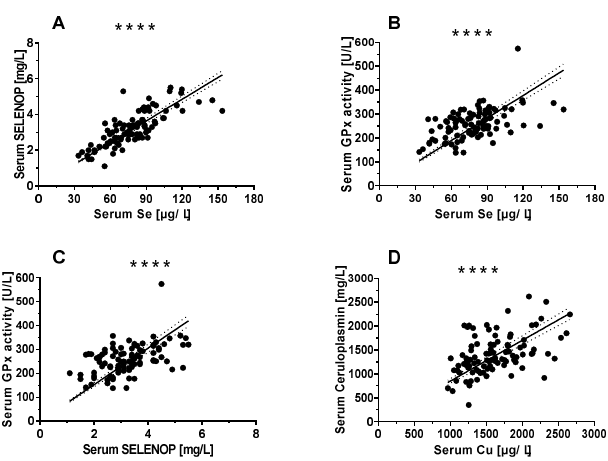
Figure 1. Selenium (Se) and Copper (Cu) status assessment from serum of the full study cohort. The concentrations of biomarkers of Se status correlate significantly in the serum samples analysed, and positive and tight correlations are observed for ( A ) selenoprotein P (SELENOP) and total Se ( n = 96 pairs of data, r = 0.792, p < 0.0001), ( B ) GPx3 activity and total Se ( n = 96, r = 0.491, p < 0.0001), as well as ( C ) GPx3 activity and SELENOP ( n = 96, r = 0.470, p < 0.0001). ( D ) Similarly, both biomarkers of Cu, i.e., ceruloplasmin (CP) and total Cu concentrations show a positive and tight correlation across the full range of values in the complete cohort of serum samples ( n = 96, r = 0.475, p < 0.0001). Correlations were analysed by Spearman’s correlation test. p -values < 0.05 were considered statistically significant; **** indicates p < 0.0001. Nutrients 2020 , 12 , x FOR PEER REVIEW The SSc patients displayed disease-specific differences in the TE status biomarkers in comparison to HC (Figure 2). To further subdivide the analyses, the group of SSc patients was differentiated according to presence or absence of PAH. A gradual decrease in Se status from HC to patients with SSc and then with SSc-PAH was observed. The group of SSc-PAH patients displayed the lowest Se status, i.e., significantly reduced concentrations of Se (Figure 2A), and SELENOP (Figure 2B), as well as reduced GPx3 activity (Figure 2C). Notably, the average levels of all three Se status biomarkers were consistently lower in patients with SSc-PAH than in HC. In comparison to established reference ranges from literature [21,43], the SSc patients displayed a relative Se deficit (Table S1); the prevalence of Se deficiency (SSc-PAH vs. SSc vs. controls) was 16.0% vs. 14.6% vs. 0% as judged by serum Se, 64.0% vs. 41.5% vs. 10% as judged by serum SELENOP, and 28.0% vs. 19.5% vs. 0% as judged by GPX3 activity, respectively.